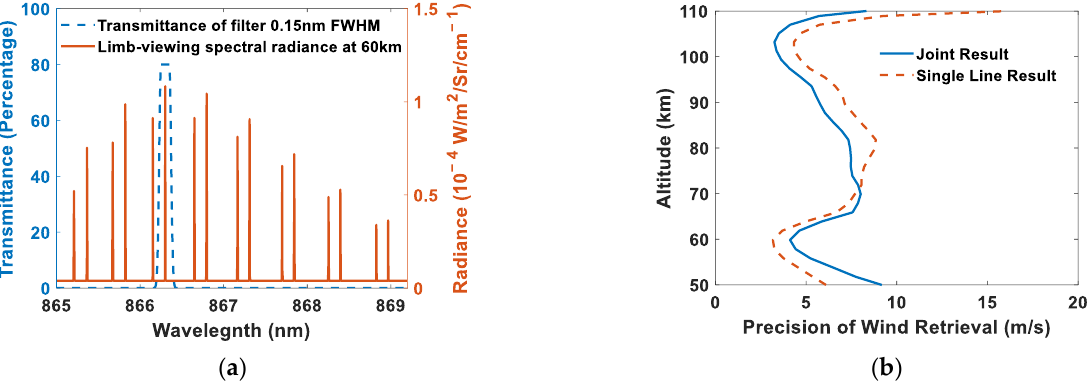
Figure 16. Single-emission-line filtering characteristics and retrieval precision comparison with the proposed joint method. ( a ) Spectral characteristics of the narrow filter and target airglow. ( b ) Com- parison of the wind retrieval precision of the joint method and the single-line isolating scheme.